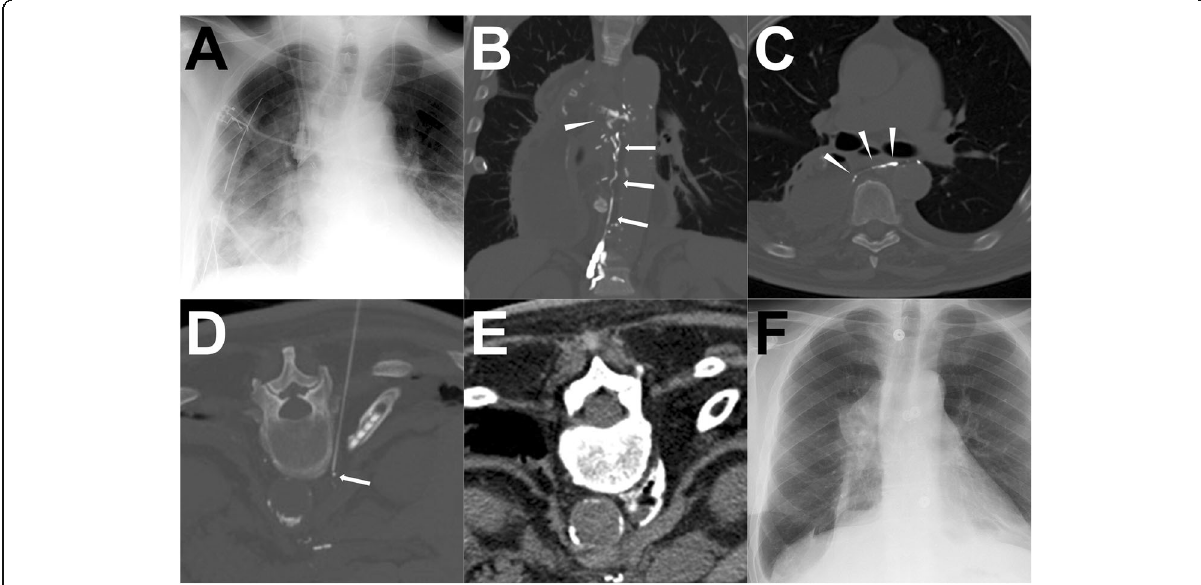
Fig. 7 A patient underwent ALVS procedure after post-LAG CT. Note: After the surgery, the right chylothorax appeared with hyperdensity of the right lower lung in the chest radiogram ( a ). The coronal MIP images of post-LAG CT demonstrated a definite rupture (white arrowhead) of the thoracic duct (white arrows) and the extravasation to the right pleural cavity ( b ). The axial MIP image demonstrated a clear rupture of the thoracic duct ( c ). The lower thoracic duct was regarded as the target afferent LV for the ALVS and a 21-G Chiba needle was used to puncture close to the lower thoracic duct ( d ). Afterwards, 1 ml contrast followed with 4.0 ml 95% Ethanol being injected. The post-ALVS CT scan showed an ideal distribution of the sclerosant around the target thoracic duct ( e ). Eleven (11) days after ALVS, the chest radiogram shows no obvious recurrence of the chylothorax ( f ). Abbreviations: ALVS – afferent lymphatic vessel sclerotherapy; post-LAG CT – post-lymphangiographic computed tomography; MIP – maximum intensity projection; LV – lymphatic